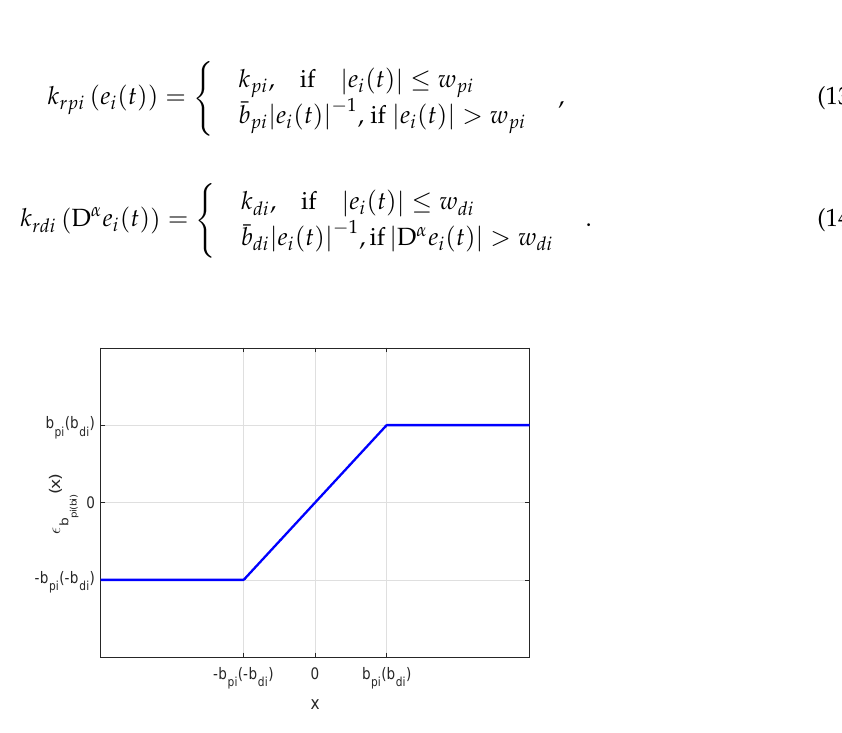
Figure 1. Saturation